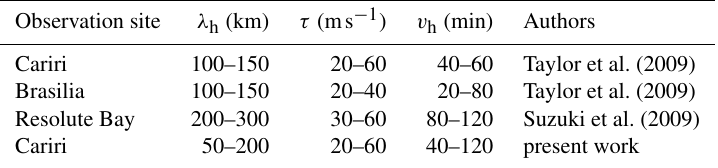
Table 4. Summary of the main distribution of MSGW characteristics at different observation